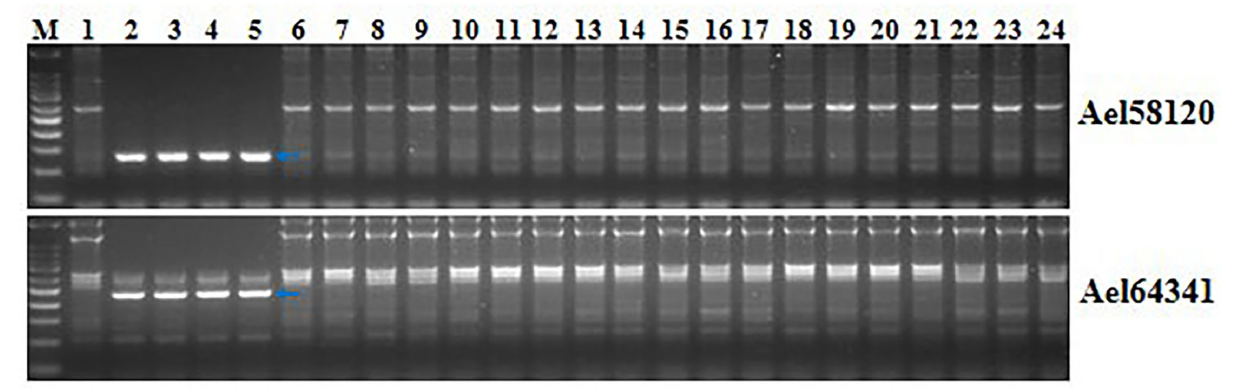
FIGURE 8 | Validation of the usefulness of two markers Ael58120 and Ael64341 closely linked to Pm6Sl . M: 100 bp DNA ladder; 1: CS; 2: CS- Ae . longissima 6S l #3 disomic addition line TA7548; 3-5: 6S l #3 recombinants R43, T24 and T27 with resistance to powdery mildew; 6: Bainong 207; 7: Bainong 64; 8: Aikang 58; 9: Zhoumai 16; 10: Zhoumai 18; 11: Zhoumai 22; 12: Zhoumai 28; 13: Pingan 0518; 14: Pingan 602; 15: Pingan 901; 16: Jimai 22; 17: Yanzhan 4110; 18: Shengxuan 6; 19: Yangmai 5; 20: Nannong 9918; 21: Linxuan 101; 22: Hua 5; 23: Ningmai 3; 24: Xinong 979. Arrows pointed to the polymorphic bands of the respective molecular markers linked to Pm6Sl